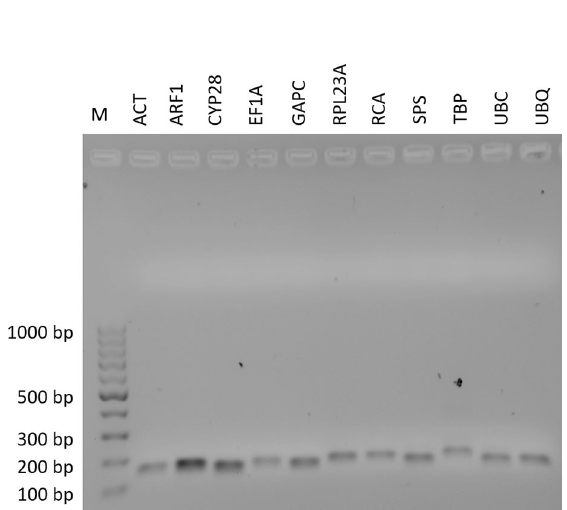
Figure 2. RT-qPCR amplification products of A. spica-venti candidate reference genes. M DNA ladder, bp base